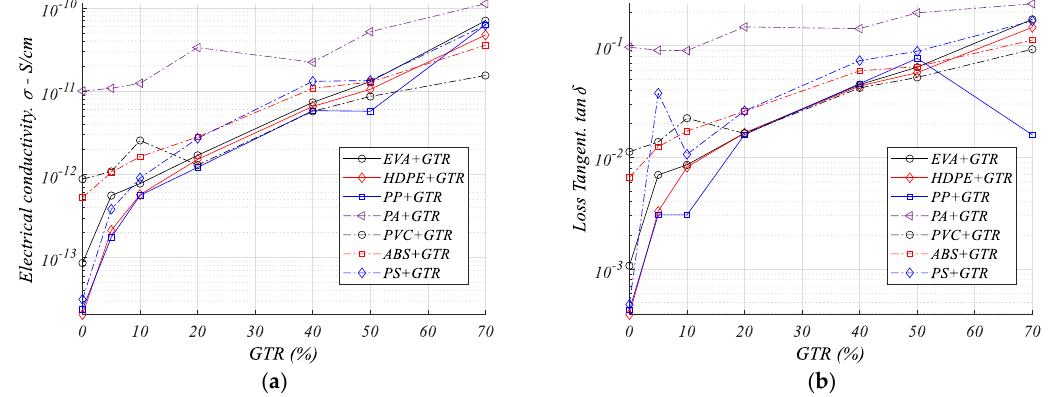
Figure 2. ( a ) Electrical conductivity (S/cm), and the ( b ) loss tangent (Tan δ) for different polymers/GTR concentrations with a particle size of <200 µm. The frequency was fixed at 50 Hz and 30 °C.